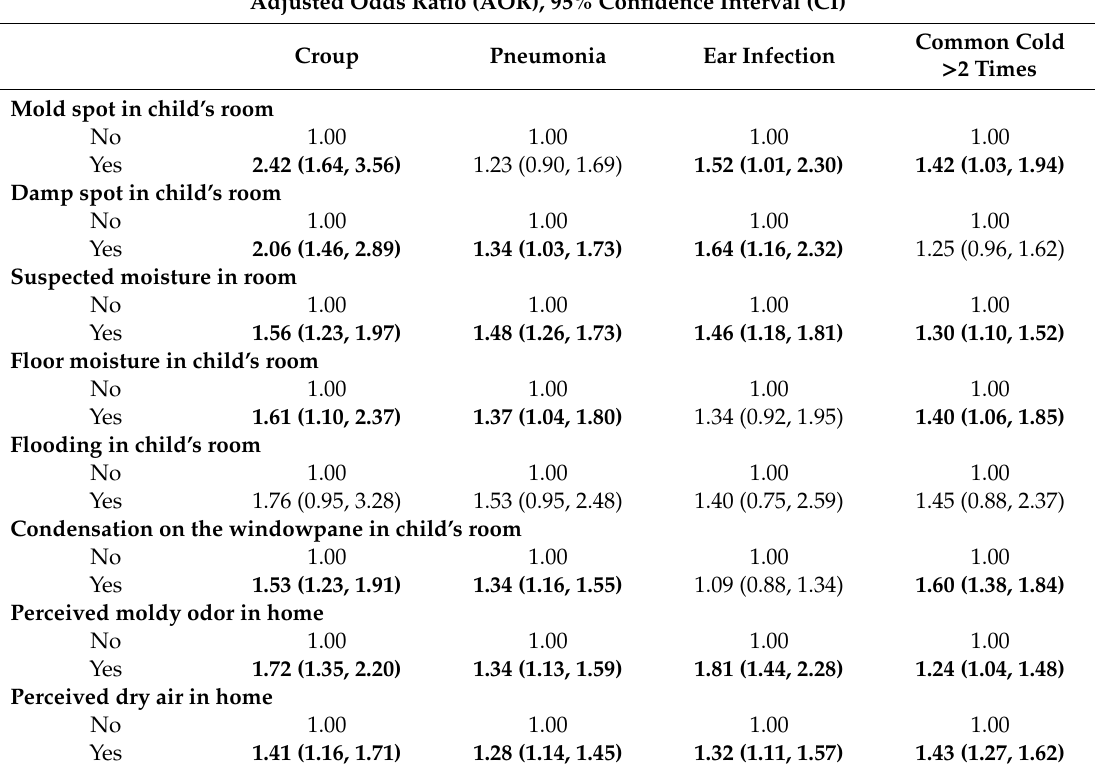
Table 2. Associations of respiratory infections with dampness and